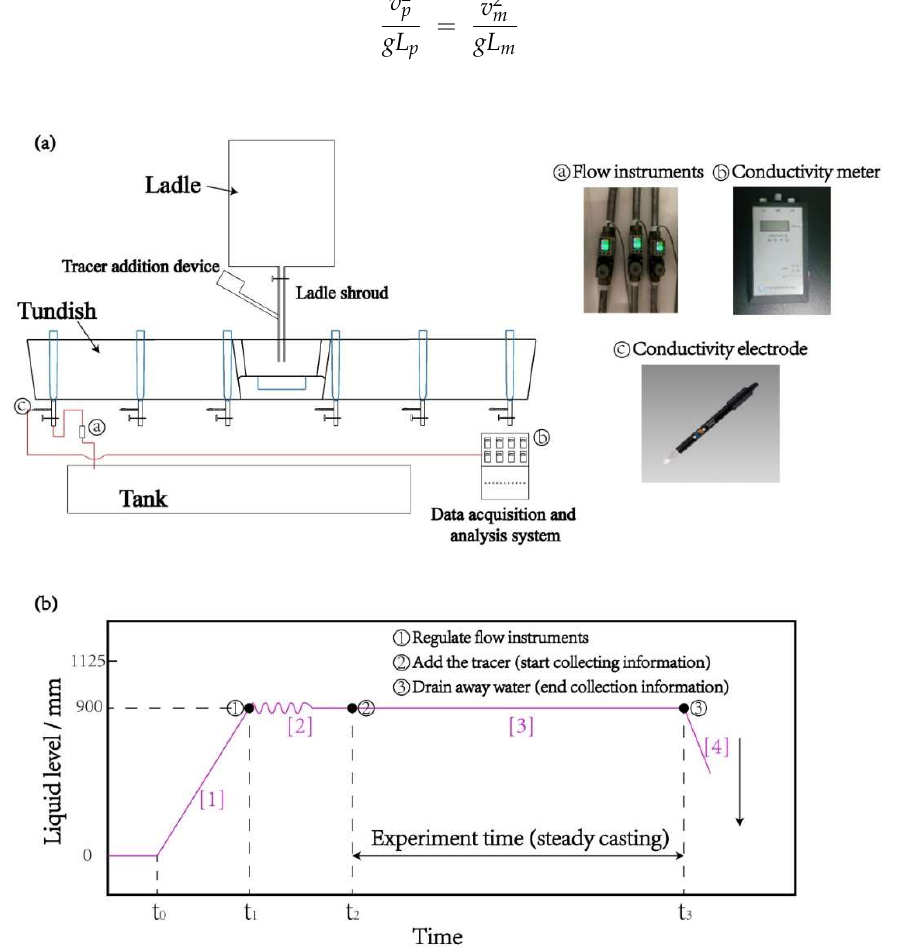
Figure4. ( a )Schematicdiagramofhydraulicsexperimentusedformeasuringresidencetimedistribution Figure 4. ( a ) Schematic diagram of hydraulics experiment used for measuring residence time (RTD) curve, ( b ) hydraulics experiment detailed distribution (RTD) curve, ( b ) hydraulics experiment detailed procedure.